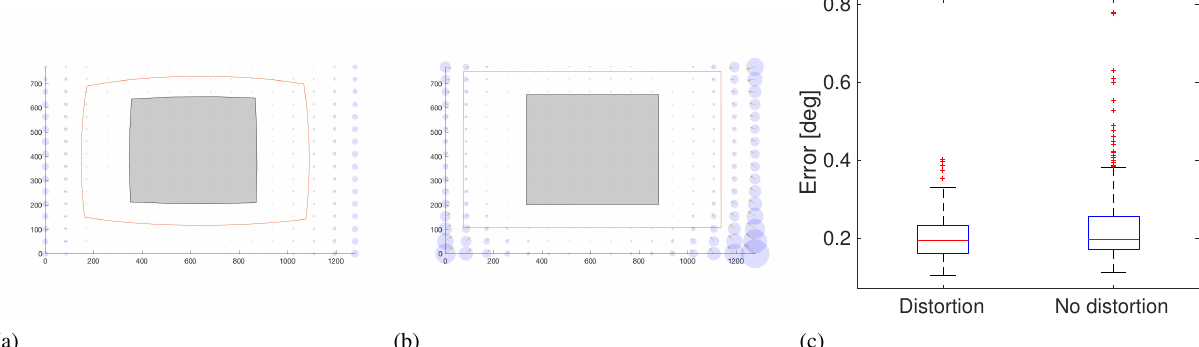
Figure 15 . Gaze estimation error in the scene image showing the e ff ect of radial distortion on polynomial function 5 (4 × 4 calibration points) (a) with and (b) without lens distortion. The error in the working area for both conditions is shown in (c).